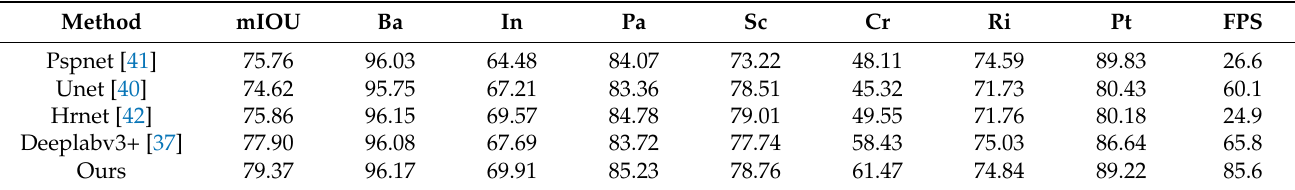
Table 5. Quantitative Comparisons of Different Segmentation Methods.